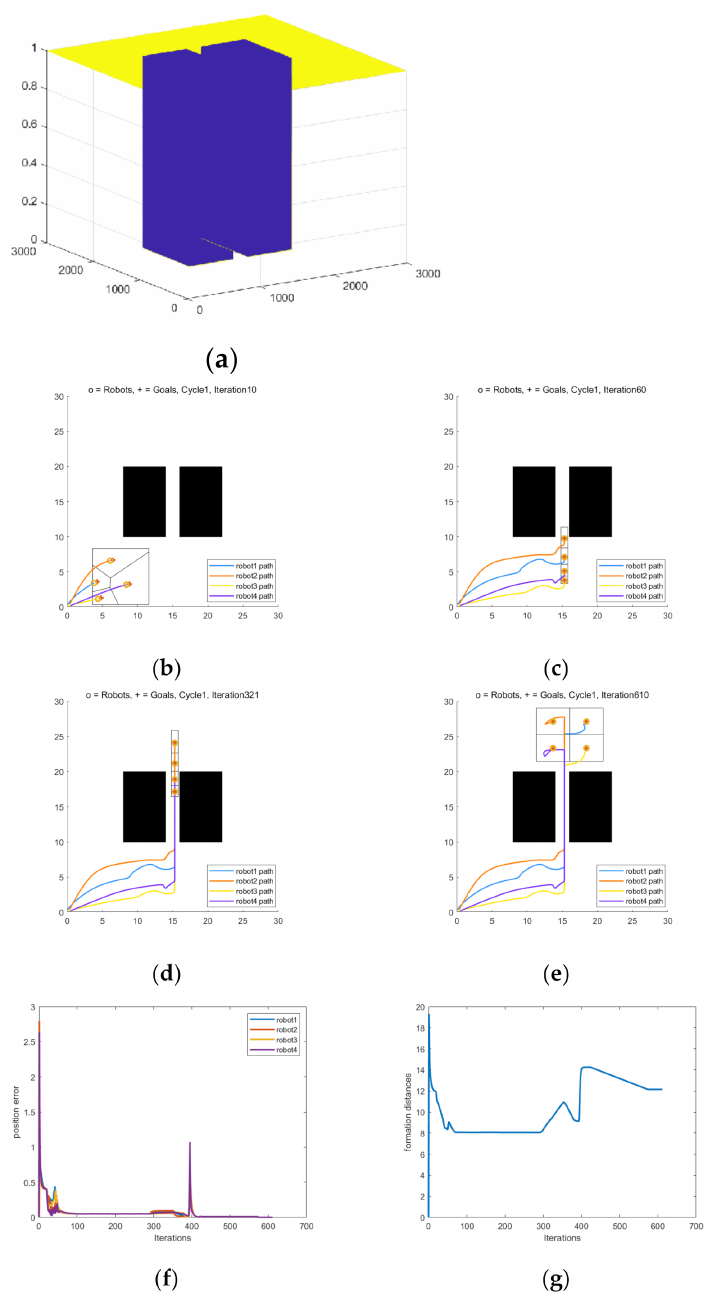
Figure 10. Dynamic formation simulation in a narrow channel: ( a ) density function distribution in a narrow channel; ( b ) k = 10; ( c ) k = 60; ( d ) k = 321; ( e ) k = 610; ( f ) position error; ( g ) formation preservation